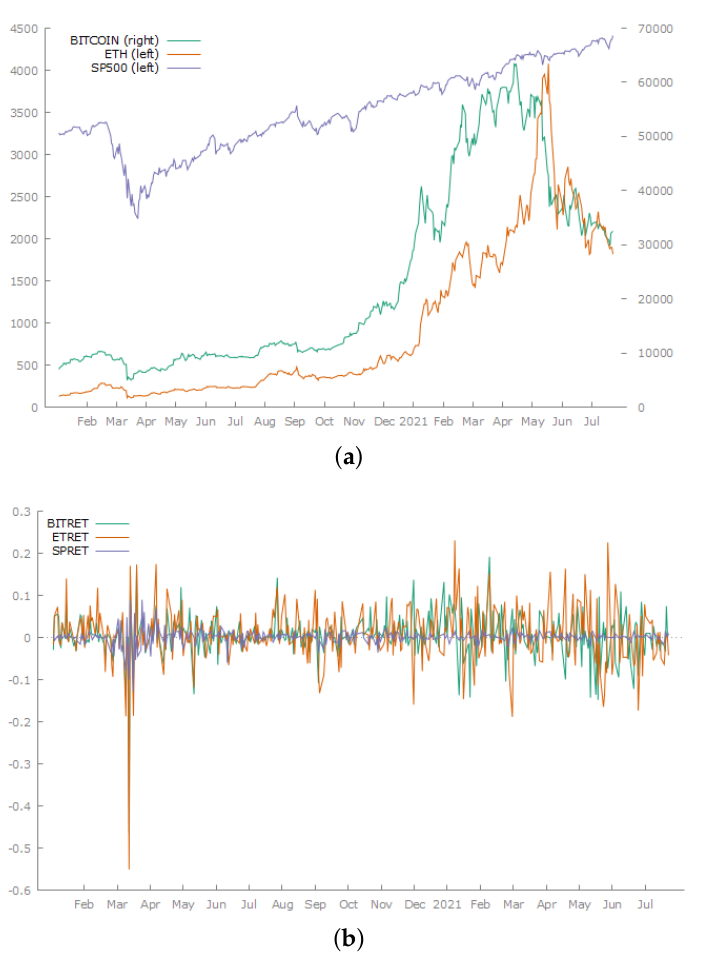
Figure 2. Plots of the series post-COVID-19. ( a ) Price series levels post-COVID-19. ( b ) Plot of returns